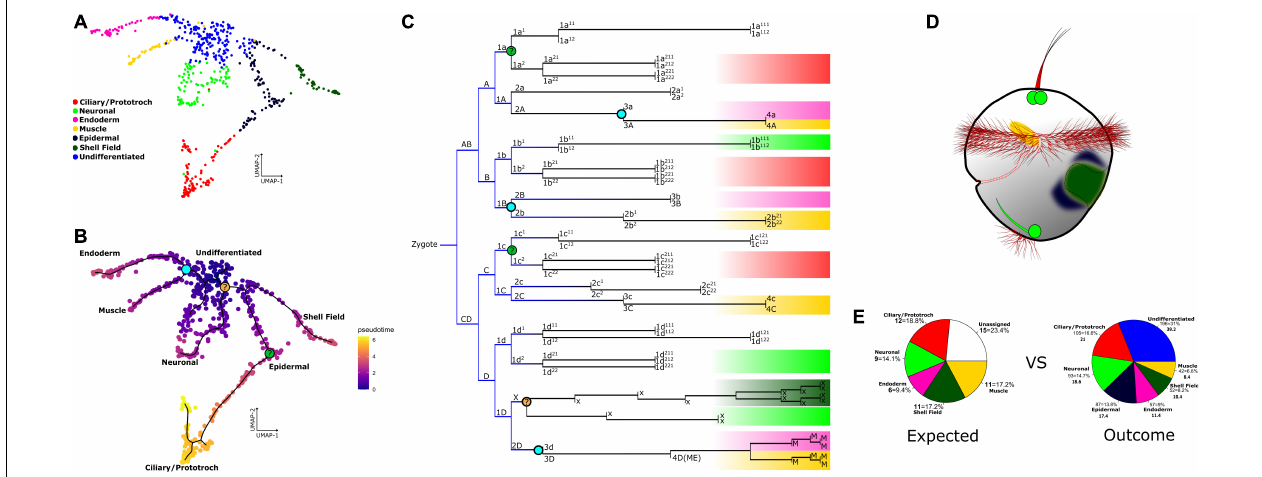
FIGURE 4 | Cell clusters mapped onto the Dreissena cell lineage tree and their location in the trochophore larva. (A) Resulting UMAP graph with cluster identification result of our annotation pipeline. Identified cell clusters are named and color-coded. (B) Calculated pseudotime showing recovered differentiation trajectories among extant clusters. Black lines represent the learned pseudotime trajectories. Colored nodes marked in the trajectory pathways and in the cell lineage tree represent the possible developmental decisions inferred from pseudotime and are drawn into the cell lineage map. The aquamarine node represents the developmental decision between endodermal and muscle cells. Light orange and light green represent the nodes that do not have a certain position on the fate map. (C) Cell lineage tree of Dreissena modified from Meisenheimer (1900) and Luetjens and Dorresteijn (1995). Highlighted are the putative terminal cell identities with the same color code from the UMAP projection. Blue gradient on the lines of early cell lineages represents the multipotency of the cells, which is lost in further cell divisions to acquire identity and could still be present in some lineages. Cell lineages not colored here mean the fate of these cell lineages was not identified in the fate map of Dreissena . (D) Putative location of clusters on the larva based on annotation methods described here. (E) Pie charts showing the percentage of cell types based on counts from cell lineage studies for one single larva (left, “expected”) vs. the percentage of cell types based on counts of this study from five larvae (right,